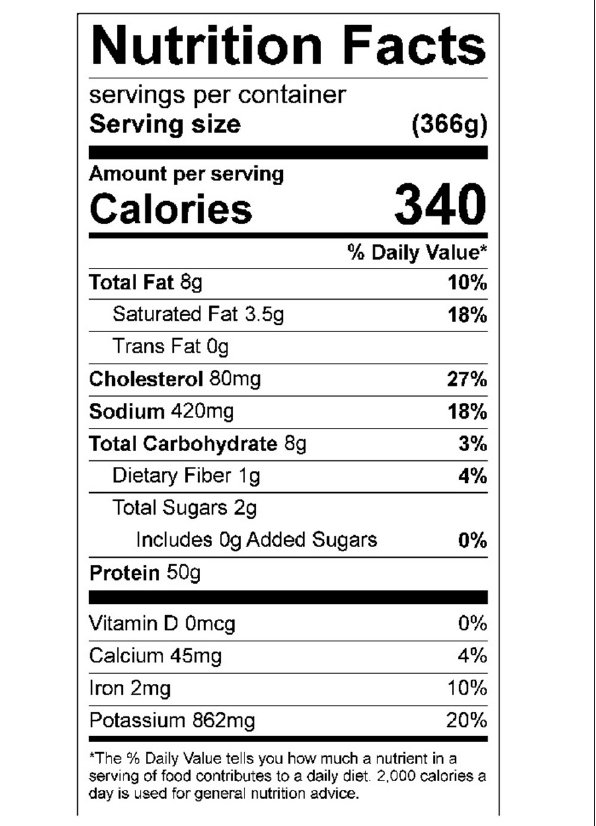
exercise of domestically raised chickens vs. wild, foraging birds, Ruffed